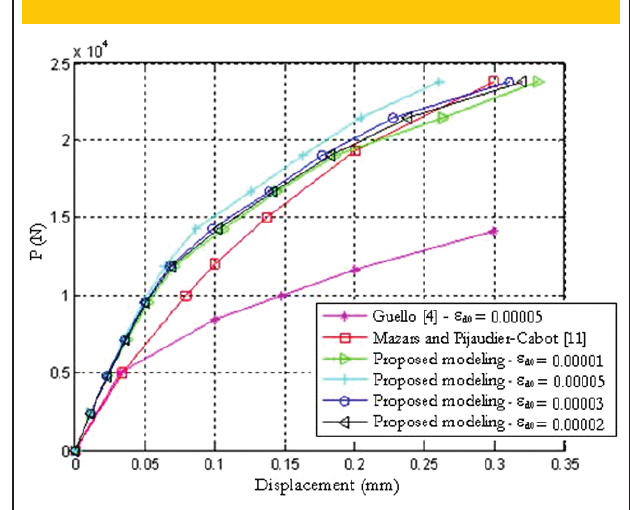
Figure 3 – Structural model of the reinforced concrete pull rod with a previous crack